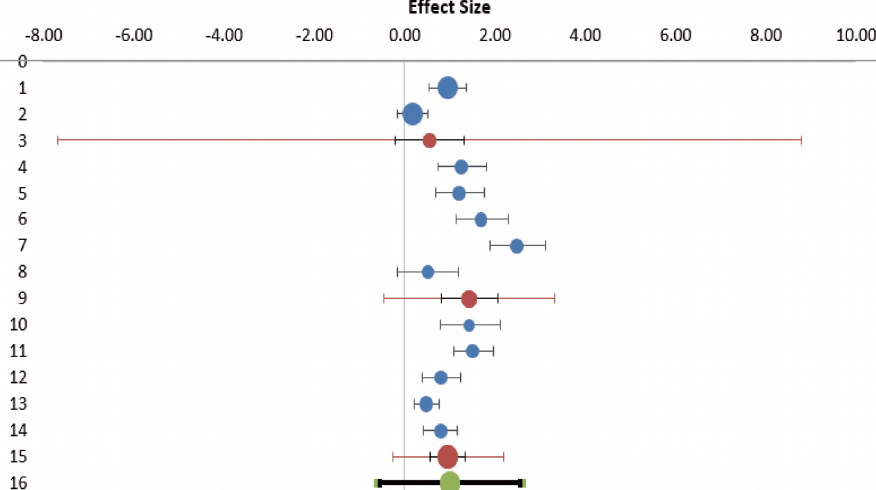
Figure 2. Forest Plot